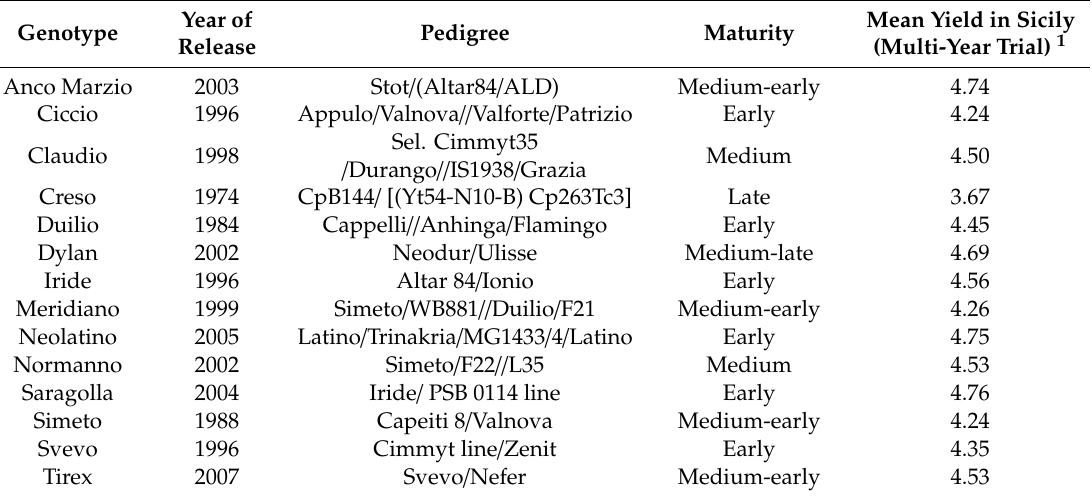
Table 1. Details of durum wheat varieties